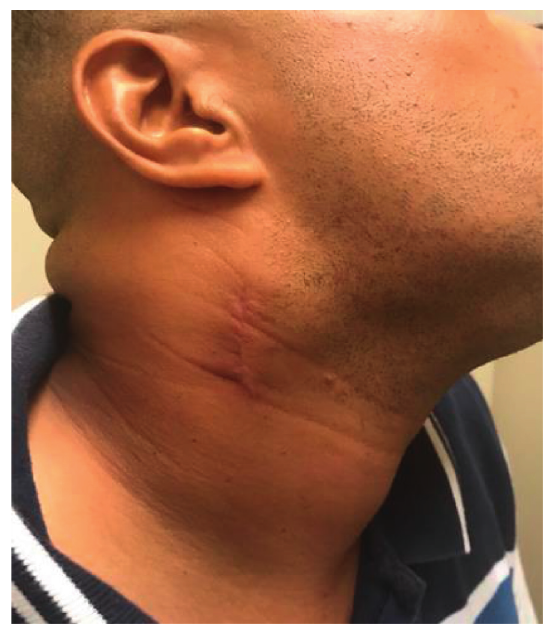
Figure 5: Progressive neck